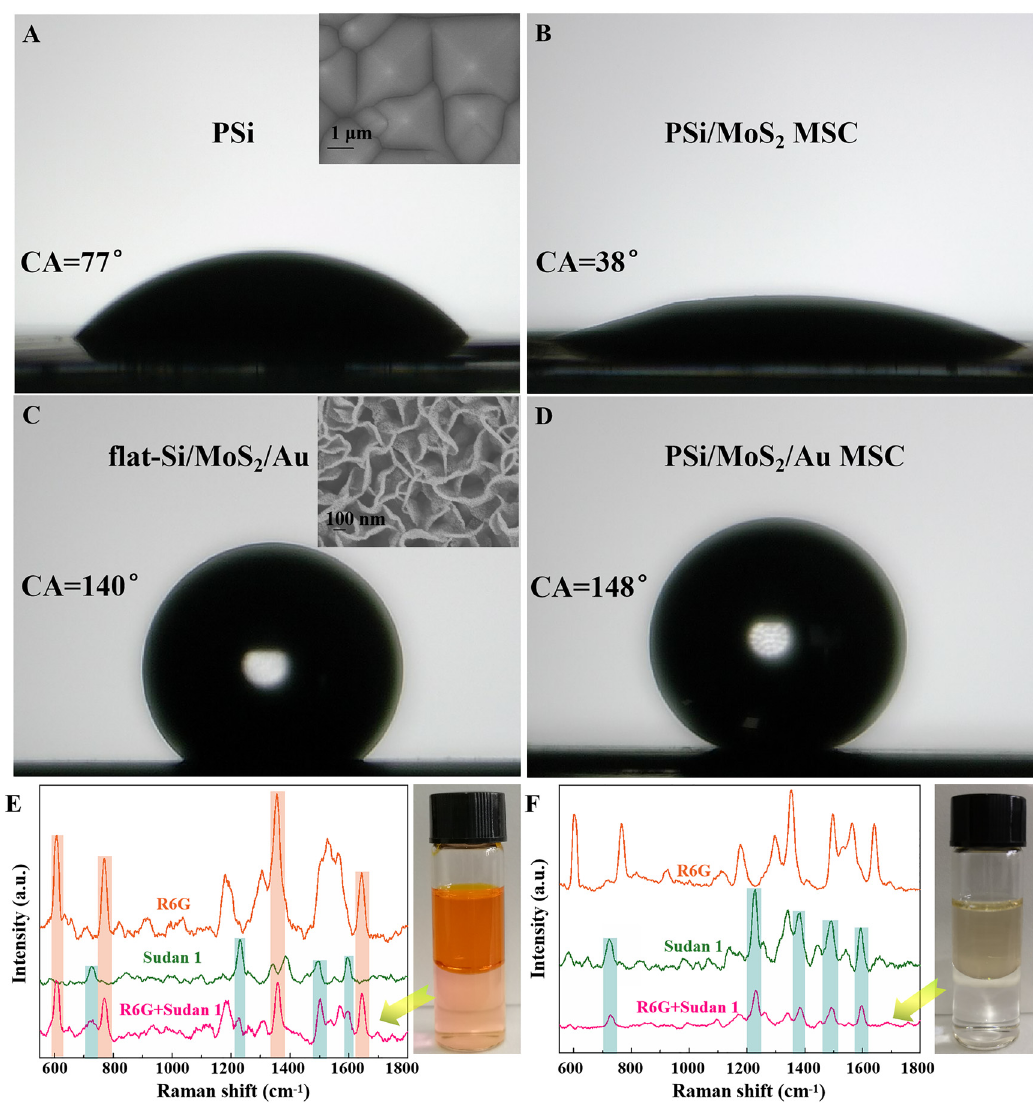
Figure 6: Hydrophobicity study of different samples. Theimagesabouthydrophobicityof(A)pyramidSi(PSi)sample(theinsetshowsthecorrespondingscanningelectronmicroscope[SEM]imageof PSi), (B) PSi/molybdenum disul fi de (MoS 2 ) multiscale cavity (MSC), (C) fl at-Si/MoS 2 /Au (the inset shows the corresponding SEM image), and (D) PSi/MoS 2 /Au MSC. (E) The surface-enhanced Raman spectroscopy (SERS) spectra of R6G aqueous solution (10 − 5 M), Sudan 1 toluene solution (10 − 3 M) and their mixture detected from PSi/MoS 2 MSC. (F) The SERS spectra of R6G aqueous solution (10 − 9 M), Sudan 1 toluene solution (10 − 5